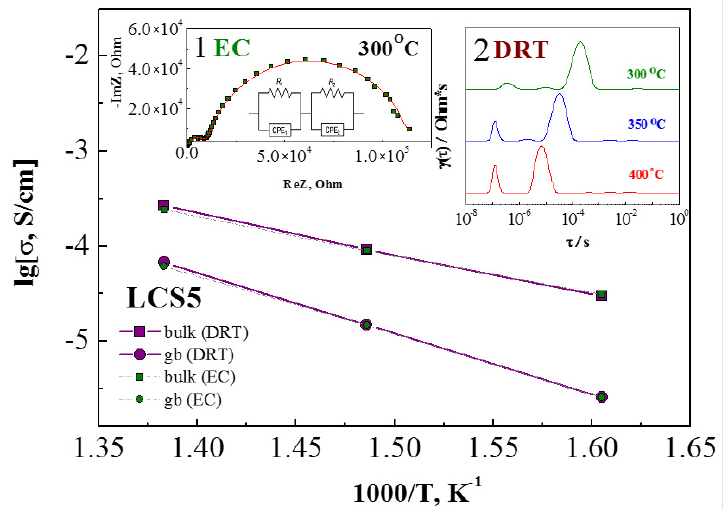
Figure 1. The temperature dependences of conductivity for LCS5 sample, obtained after interpretation by two independent methods, such as EC—equivalent circuit (insert 1), and DRT—relaxation time distribution (insert 2).